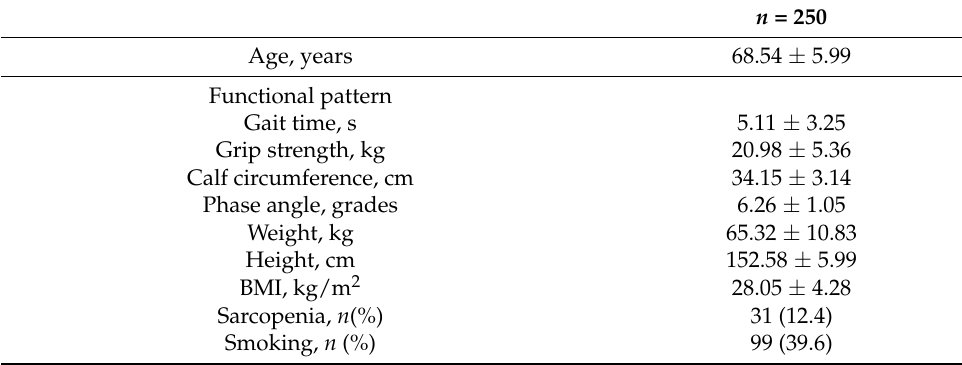
Table 1. General characteristics of the